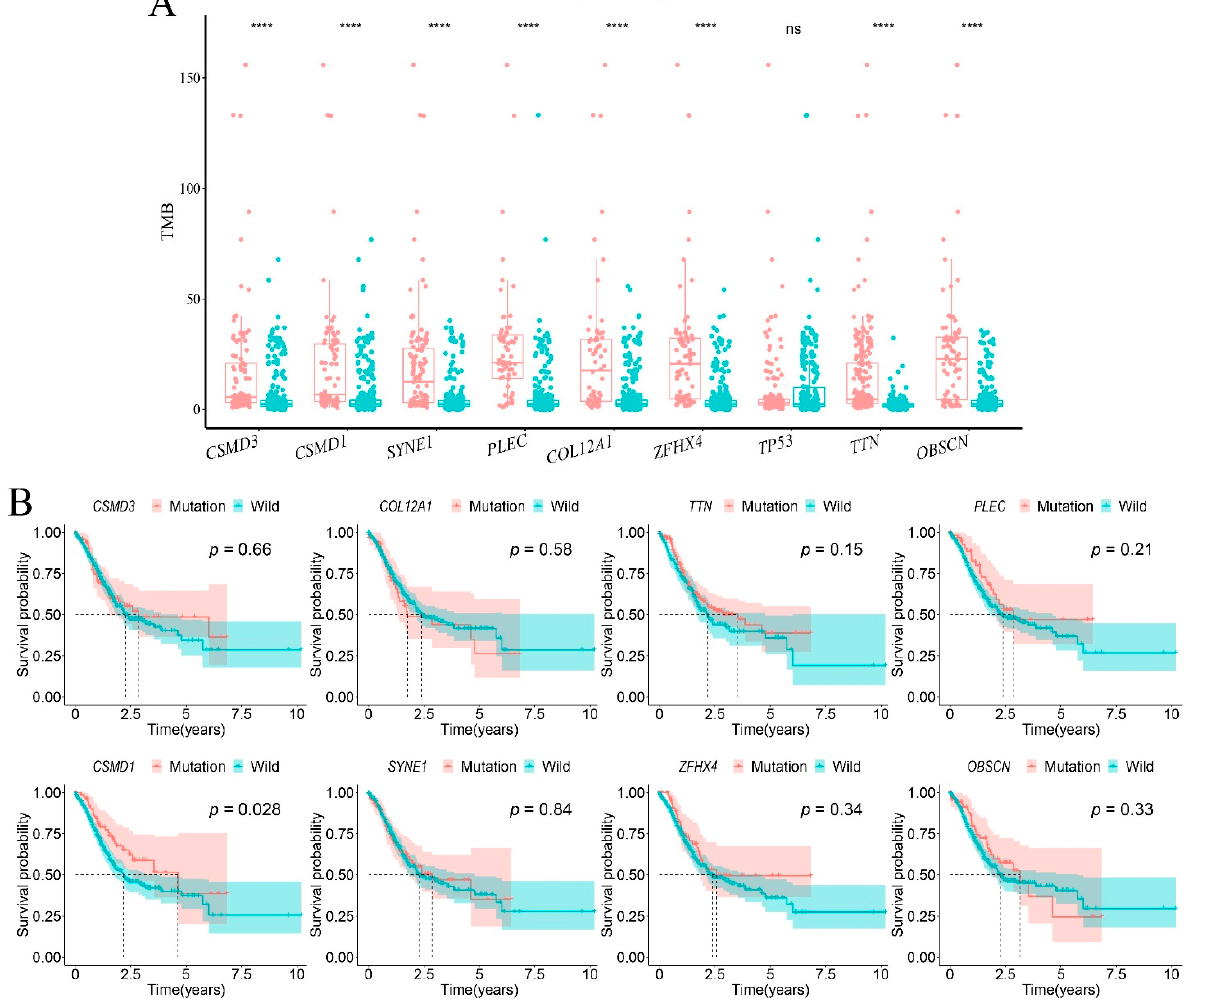
Figure 2. The correlation between gene mutation, TMB, and survival. ( A ) The box plot shows that all of the other eight gene mutations except TP53 , were associated with TMB. In the t -test, **** p < 0.0001; ns, p >= 0.05. ( B ) The survival curve showed that only CSMD1 -mut is associated with survival time in patients. The p -value in the log-rank test is marked in each diagram.